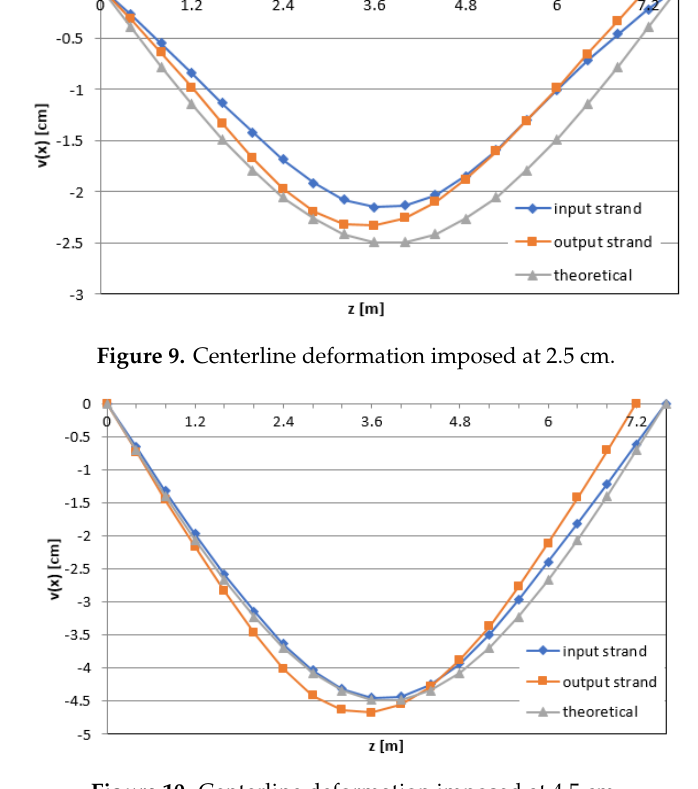
Figure 11. Centerline deformation imposed at 6.5 cm. The difference shown in the graph between the measured values and the theoretical model could undoubtedly be attributed to the fact that the theoretical values refer to the axis of the pipe, while the measured ones refer to the fiber positioned at the boundary of the cross-section. 3.2. Test 2: Horizontal Inclinometer Measurement and GG Transducer In Figure 10, the GG transducer strain measures from NSHT are compared with the strain calculated from the displacement derivative of the inclinometer measurements.